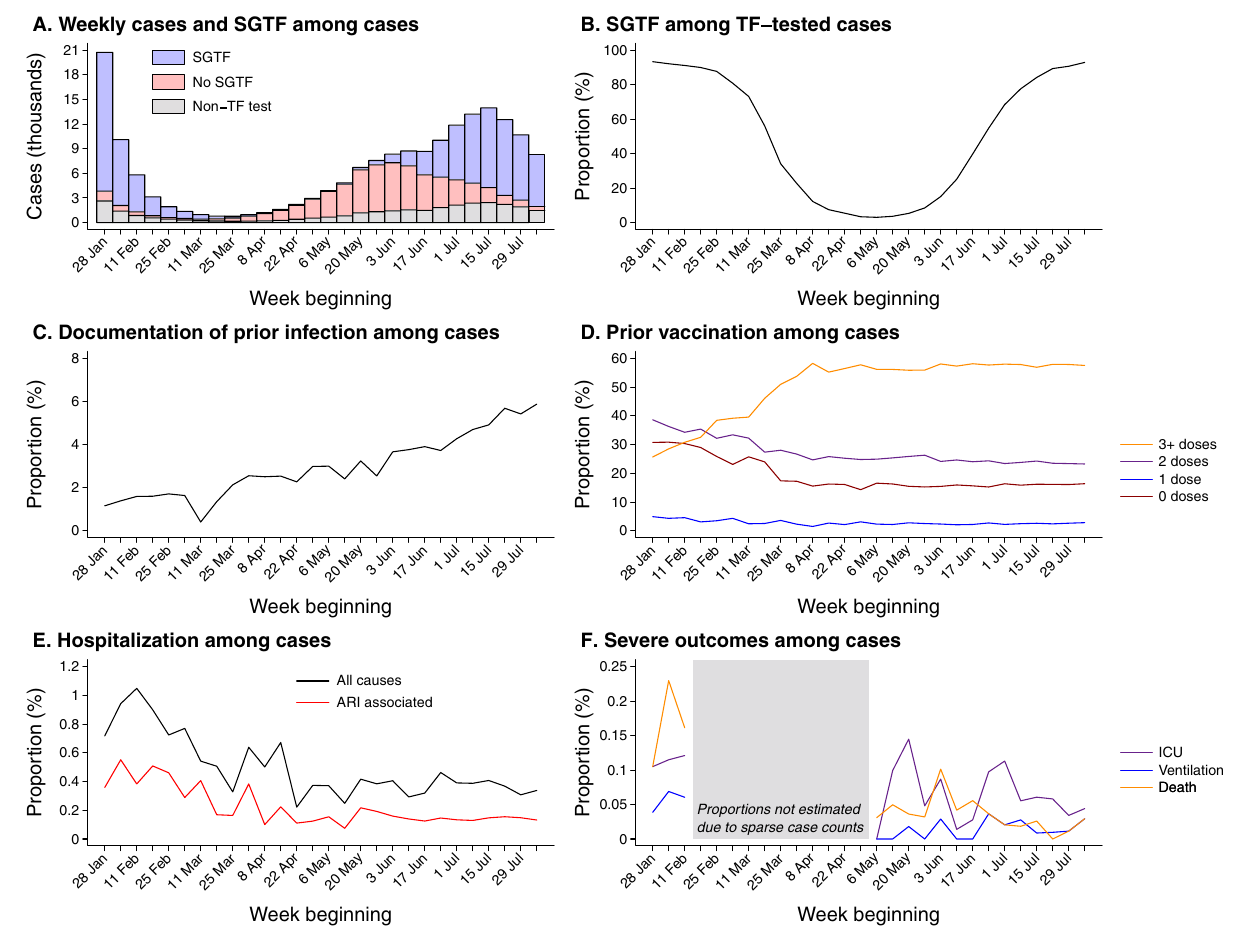
Fig. 1 | Attributes and clinical outcomes among cases diagnosed in outpatient settings. We fi rst illustrate total outpatient-diagnosed cases, distinguishing those not tested using the TaqPath ThermoFisher COVID-19 Combo Kit (TF) assay and those determined to exhibit or not exhibit S gene target failure (SGTF; A ). All subsequent plots are restricted to the eligible sample of outpatient cases tested using the TF assay, including the proportion of cases exhibiting SGTF ( B ); the proportion of cases with a history of prior documented infection ( C ); the propor- tionof caseswhopreviouslyreceived 0,1, 2, or ≥ 3COVID-19vaccine doses( D );the